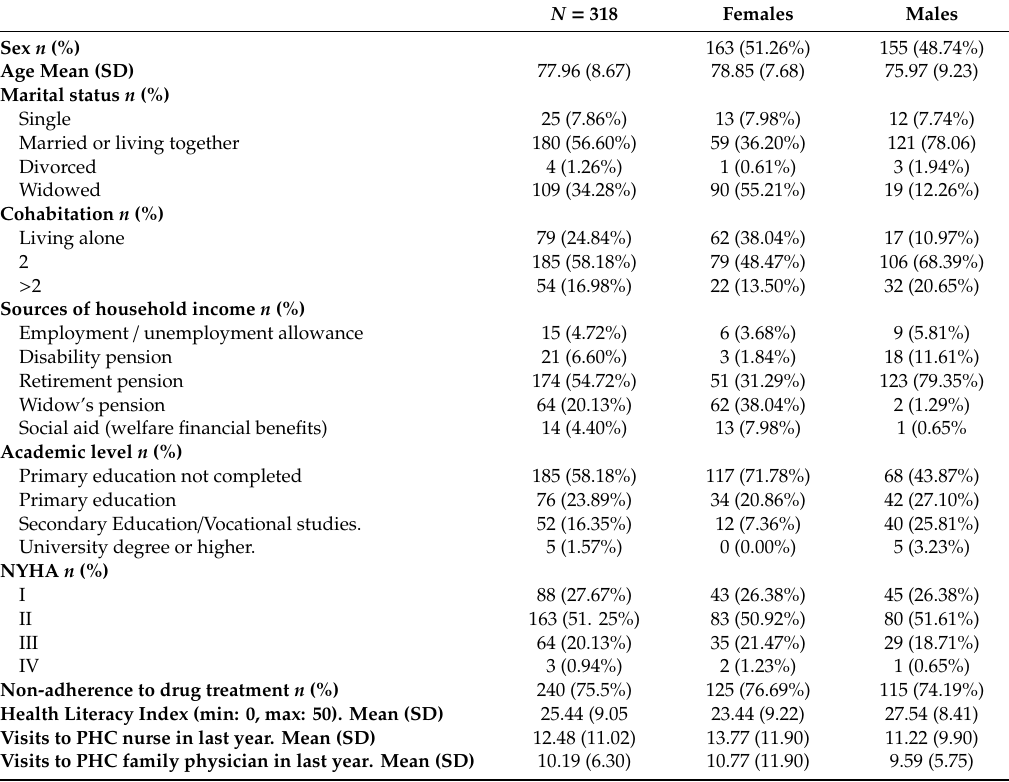
Table 1. Participant characteristics. New York Heart Association (NYHA) Functional Classification.